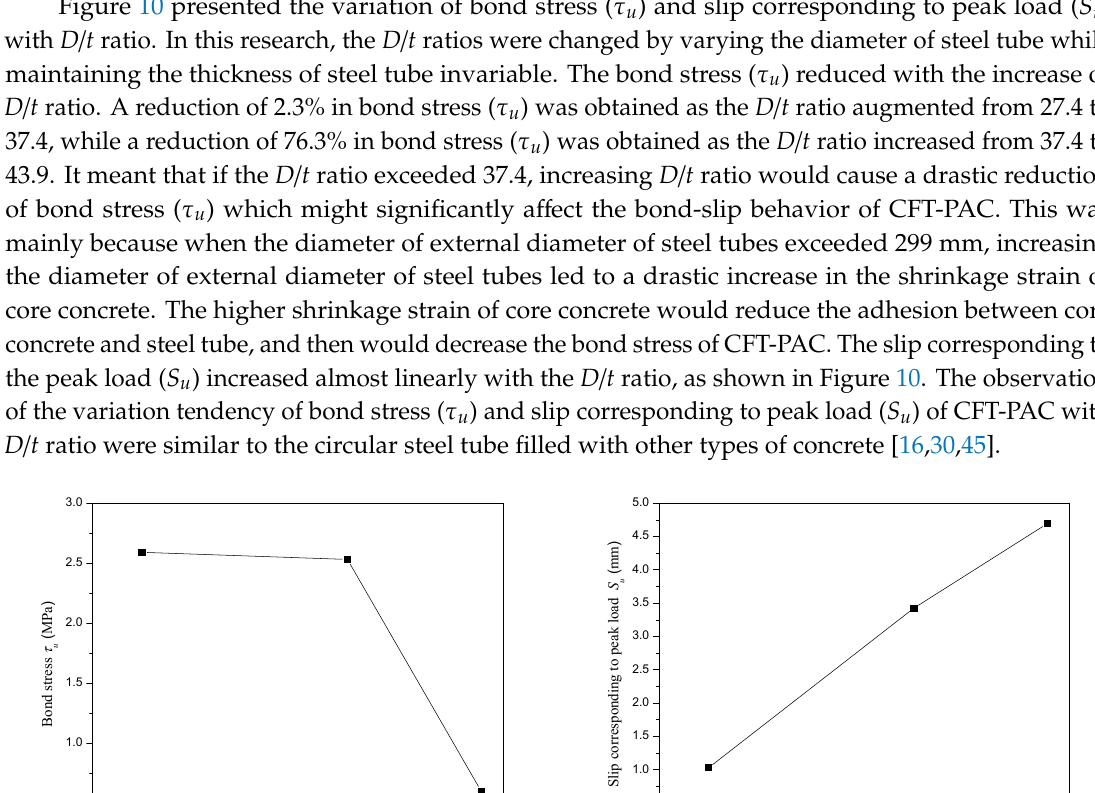
Figure 9. Variation of bond stress ( τ u ) and slip corresponding to peak load ( S u ) with L/D ratio. ( a ) Bond stress ( τ u ); ( b ) Slip corresponding to peak load ( S u ).